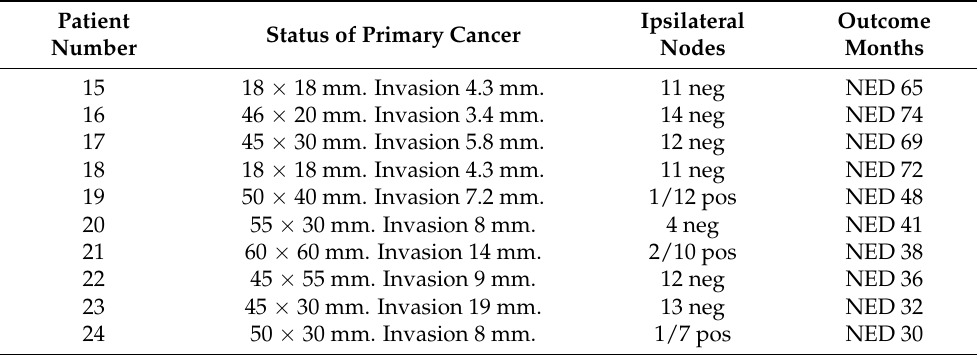
Ipsilateral Nodes